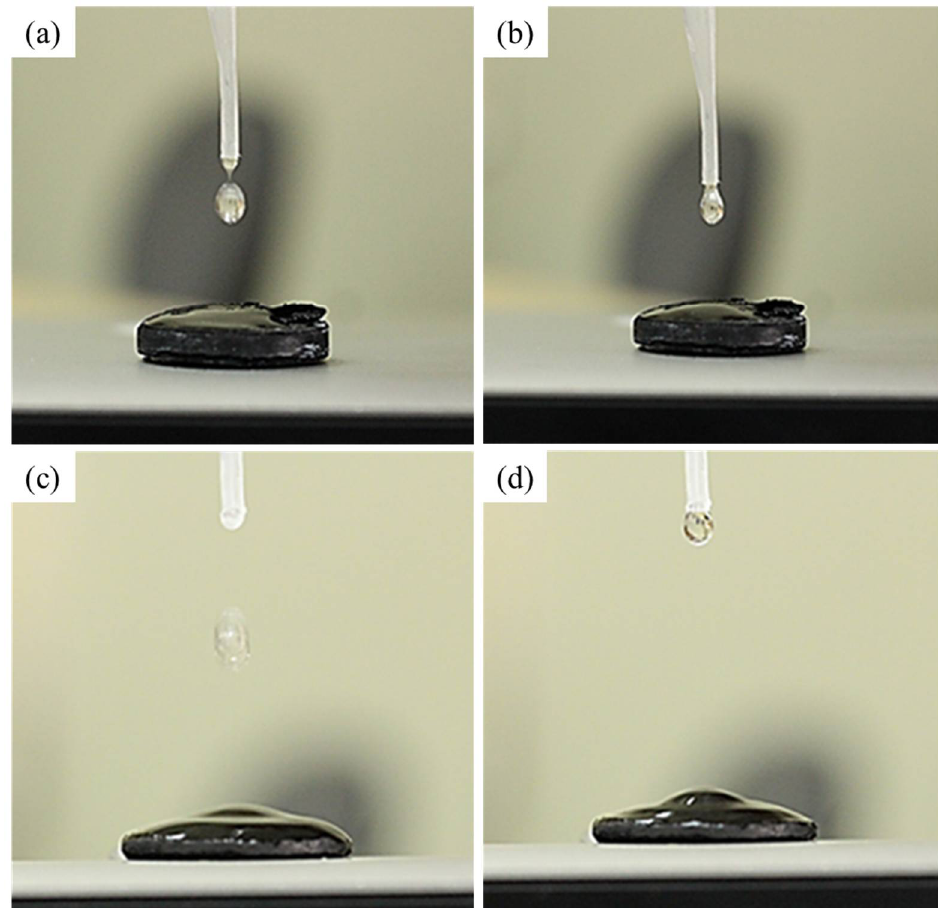
Figure 14. Contact angle measurement ( a , b ) images of raw MWCNT membranes; ( c , d ) images of MWCNT-Ag membranes.